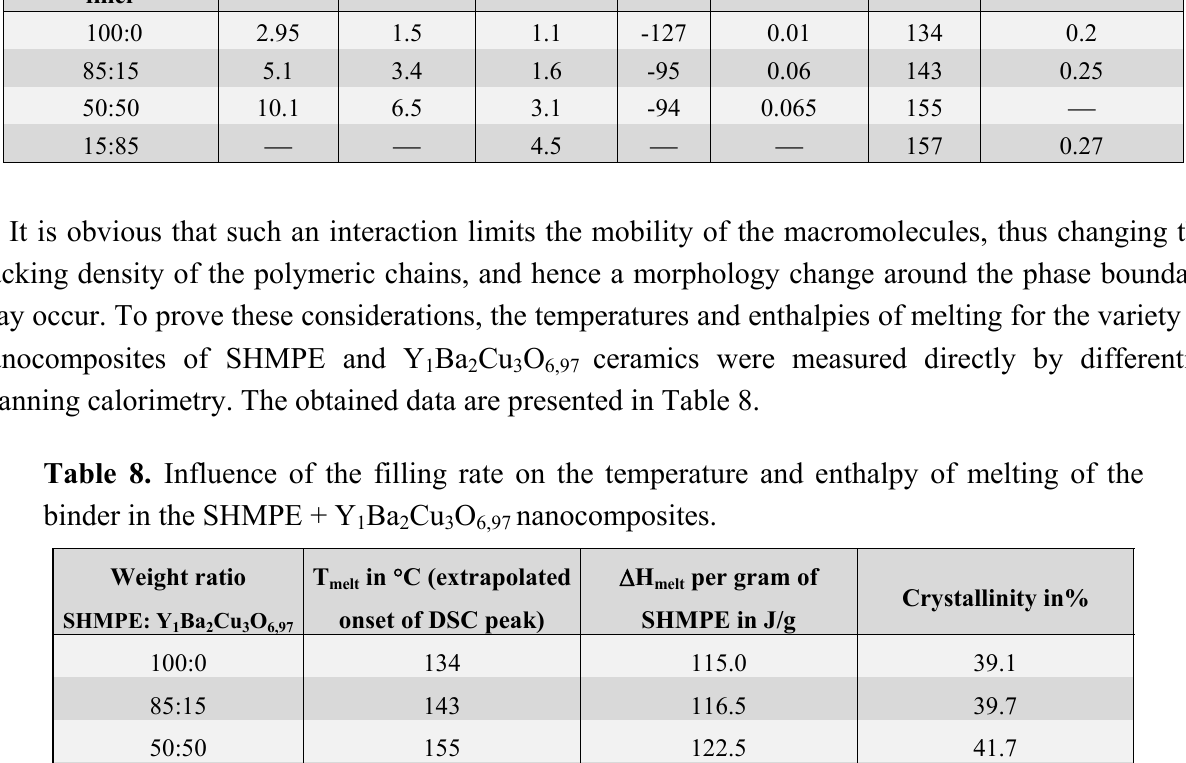
Ba Cu O with 1 2 3 6,97